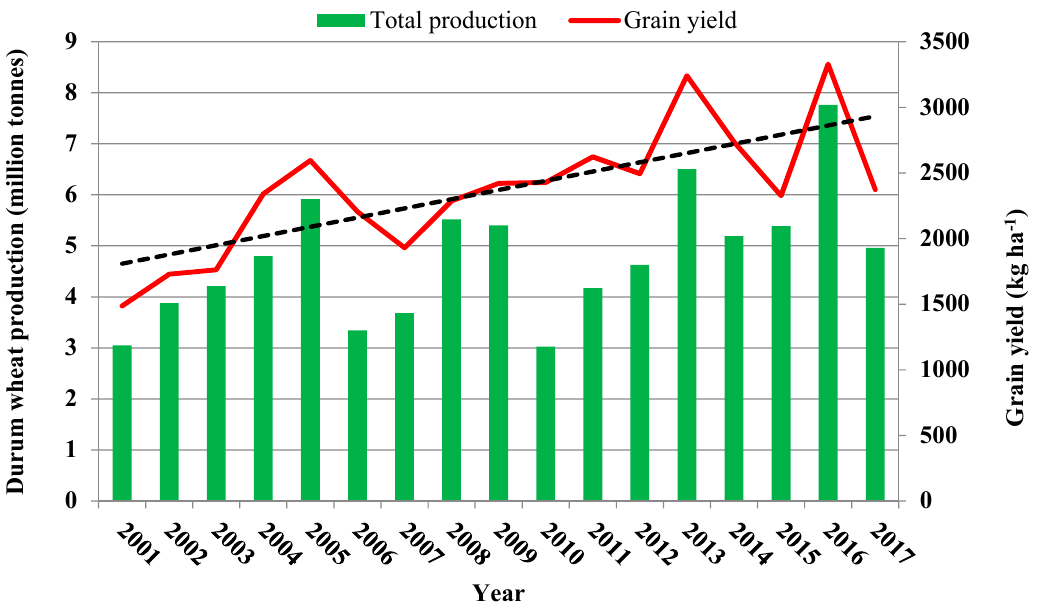
Figure 3. Canadian durum wheat production (in million tons) and average grain yield (in kg ha − 1 ) from 2001 to 2017 [7]. Linear relationship (in dotted line) between grain yield and year was grain yield = 70.2 × year + 1739.1.